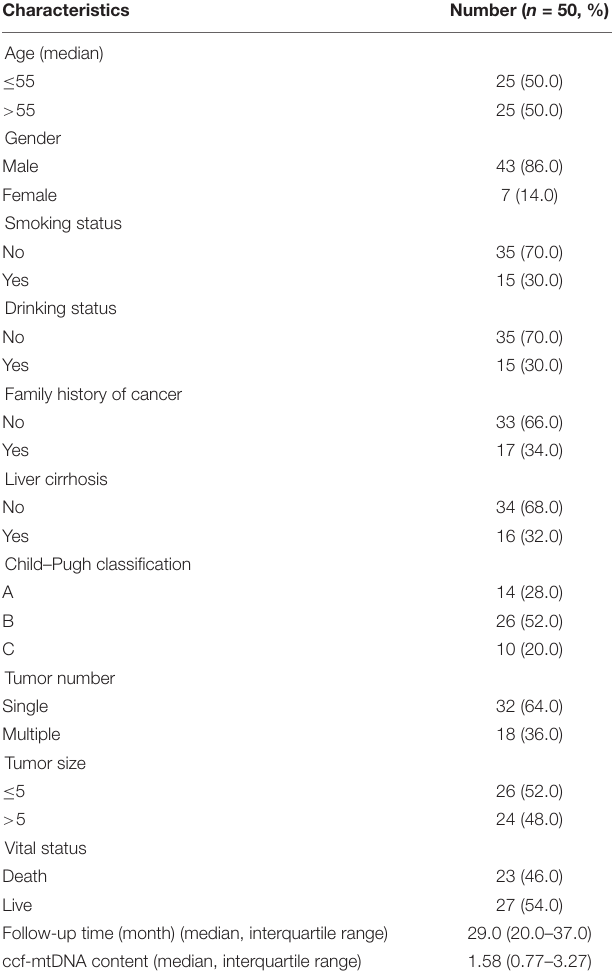
TABLE 3 | Characteristics of the HBV-HCC subcohort with TACE and TCM treatments. Characteristics